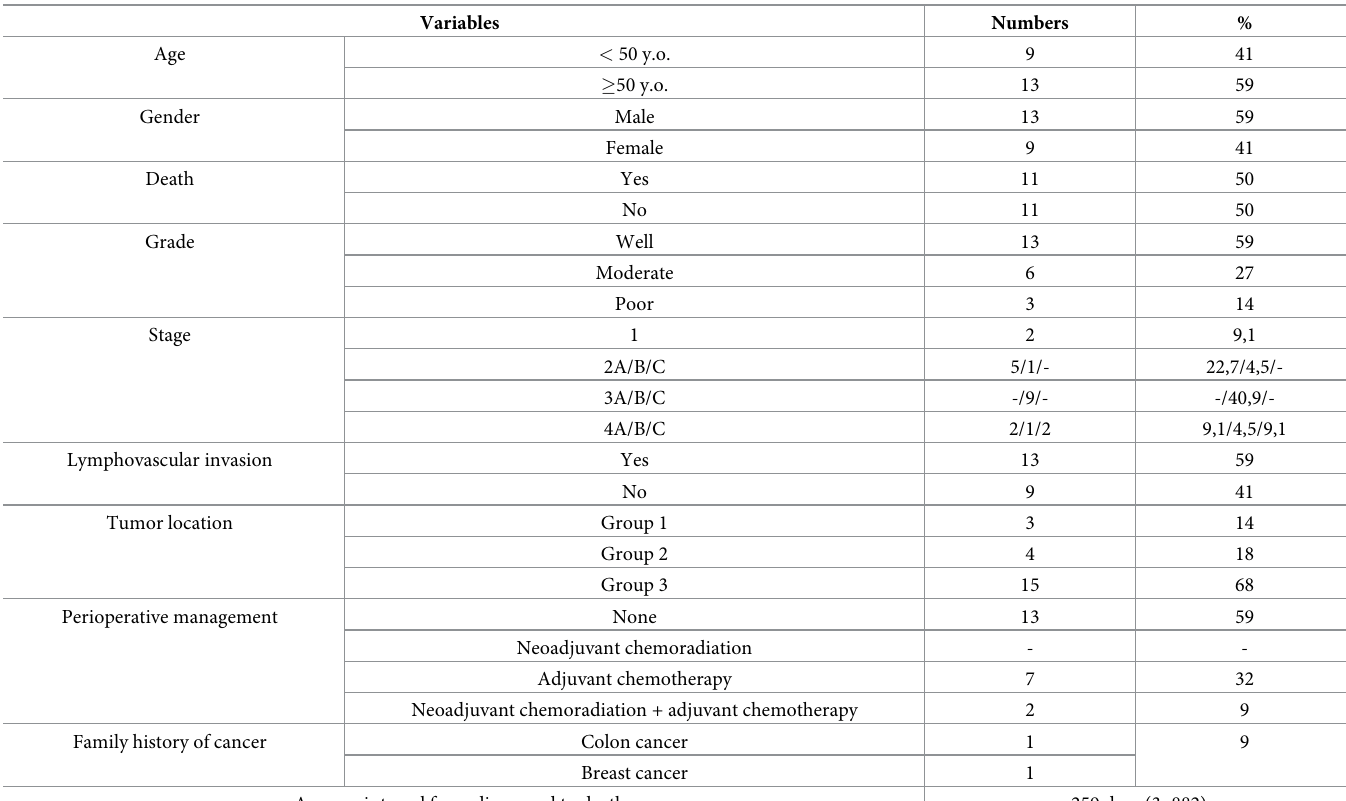
Table 11. Patients